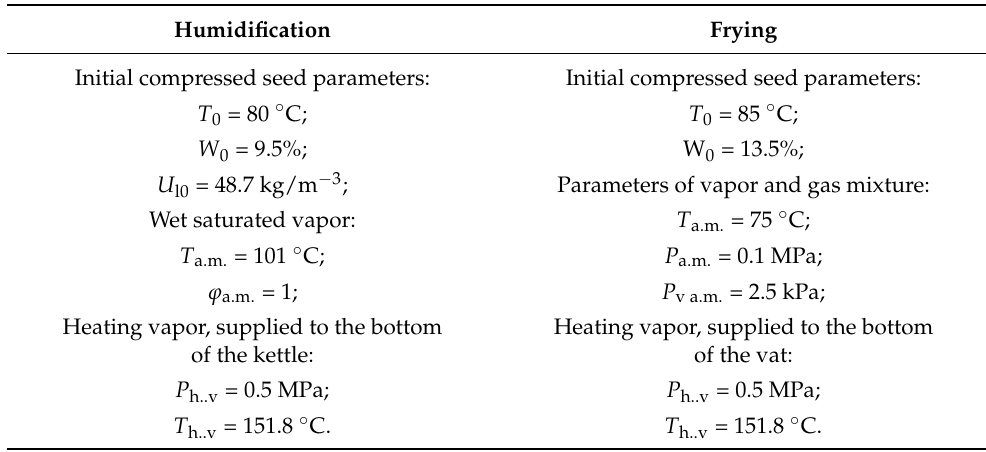
Table 1. Initial data for the compressed castor seed and the